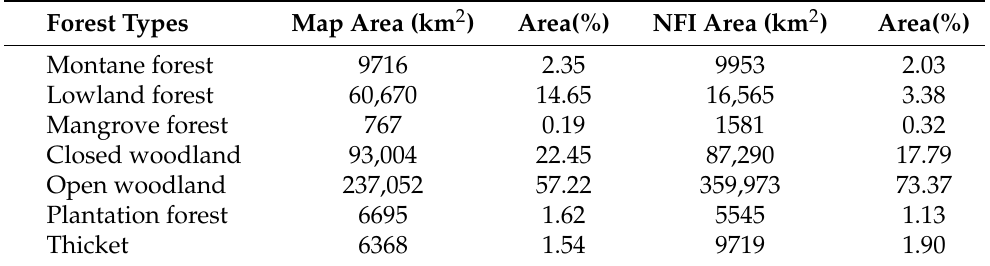
Figure 7. ( a ) Classification results; ( b ) ESRI satellite image, which highlights a detailed sample of woodland landscape with a mosaic of closed and open woodland overlaid with forest inventory plots, and ( c ) the estimated probability of mapped forest type overlap (mosaic). Similarly, the mosaic pattern tends to increase on the woodland landscape as compared to other forest types. This makes separability, and hence accuracy assessment, challenging. Table 8. Estimated area for forest type classification as compared with the National Forest Inventory (NFI) NAFORMA assessment